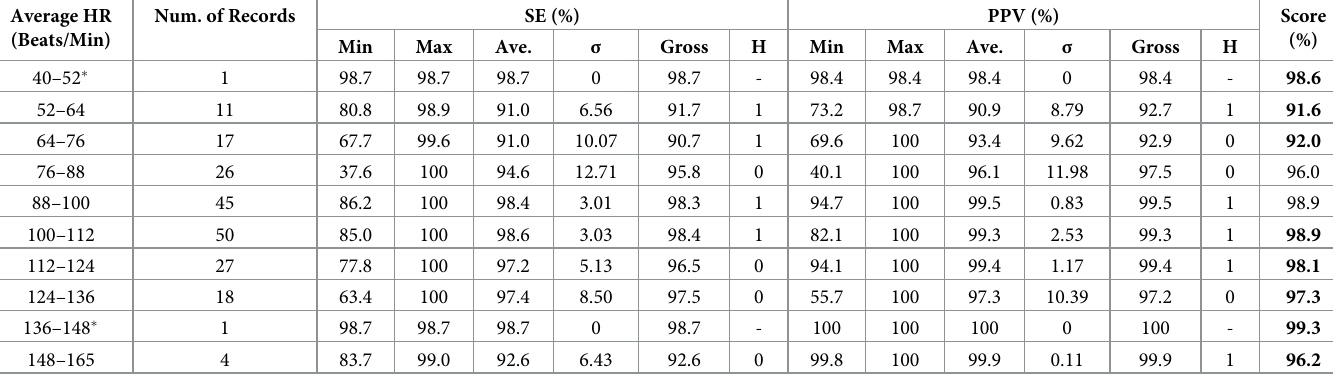
Table 5. Performance scores of challenge database grouped by average heart rate (HR). Average HR Num. of Records (Beats/Min)